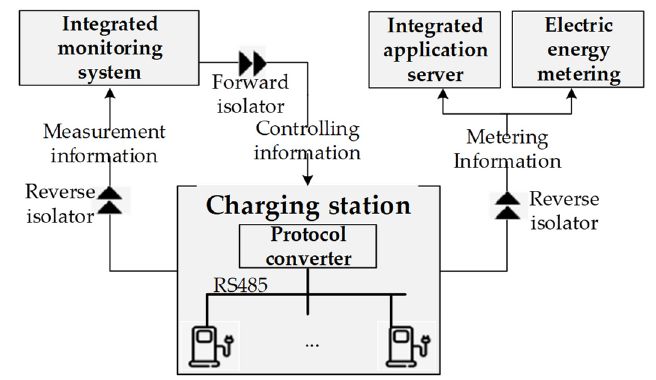
Figure 7. Isolation scheme between the charging station and other systems.